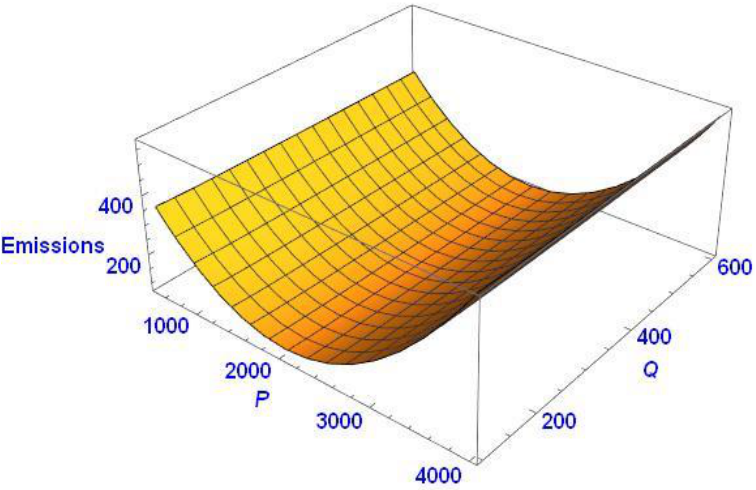
Figure 2. Amount of emissions versus the Q and P .